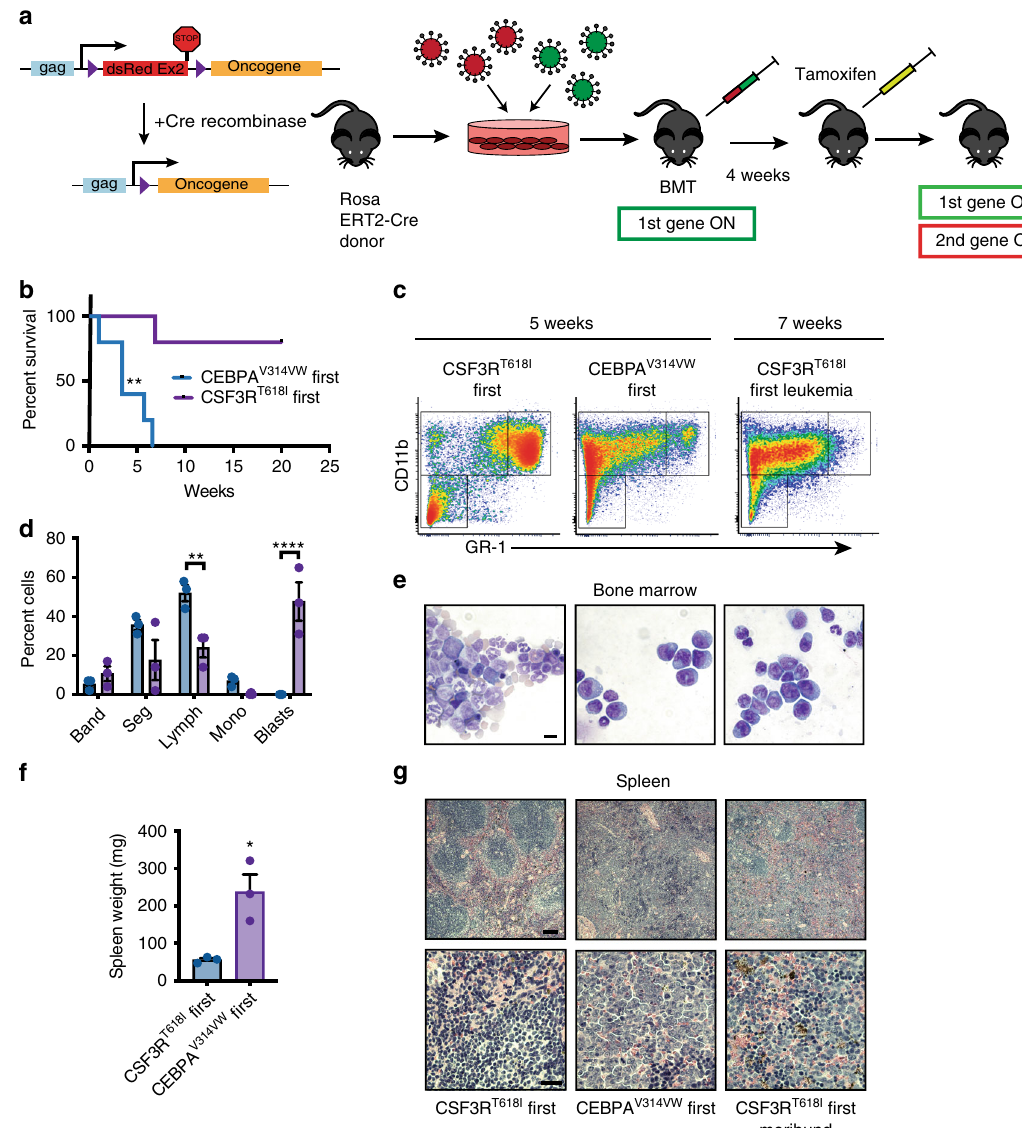
Fig. 7 CEBPA mutations must precede mutations in CSF3R for AML initiation. a Diagram of order of acquisition system. Oncogenes in the MIG vector tagged with GFP are constitutively expressed and oncogenes in the idsRed vector are expressed only after Cre mediated recombination. Expression of the second oncogene can be induced by administration of tamoxifen. Mice were administered 75,000 GFP/RFP-positive cells. b Survival reported as time from day 1 of tamoxifen induction ( n = 5/group). Statistical signi fi cance calculated by Log Rank test, ** p < 0.01. c Expression of CD11b and GR-1 in bone marrow at 5 weeks in moribund CEBPA V314VW - fi rst mice, healthy CSF3R T618I - fi rst mice or at 7-weeks in leukemic CSF3R T618I - fi rst mice (only one animal represented by CSF3R- fi rst leukemia, others are representative of 3/group). d Manual differentials of peripheral blood from mice 5 weeks after tamoxifen induction ( n = 3/group), ** p < 0.01, **** p < 0.0001. e Representative bone marrow histology (scale bar represents 10 μ m). f Spleen weight of mice sacri fi ced at 5 weeks post tamoxifen treatment, * p < 0.05 as calculated by Student ’ s T -test g Representative spleen histology (scale bar represents 100 μ m for upper panels and 20 μ m for lower panels). In all cases, values are represented as mean with error bars representing SEM. Source data are provided as a Source Data fi